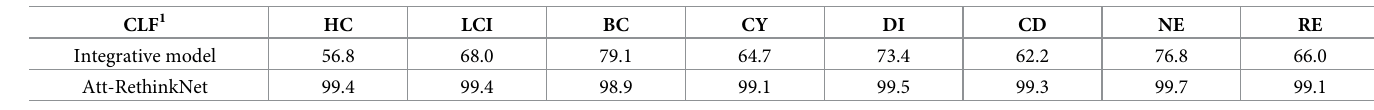
Table 12. ACC lab of the integrative model and Att-RethinkNet for kidney data. CLF 1 HC LCI